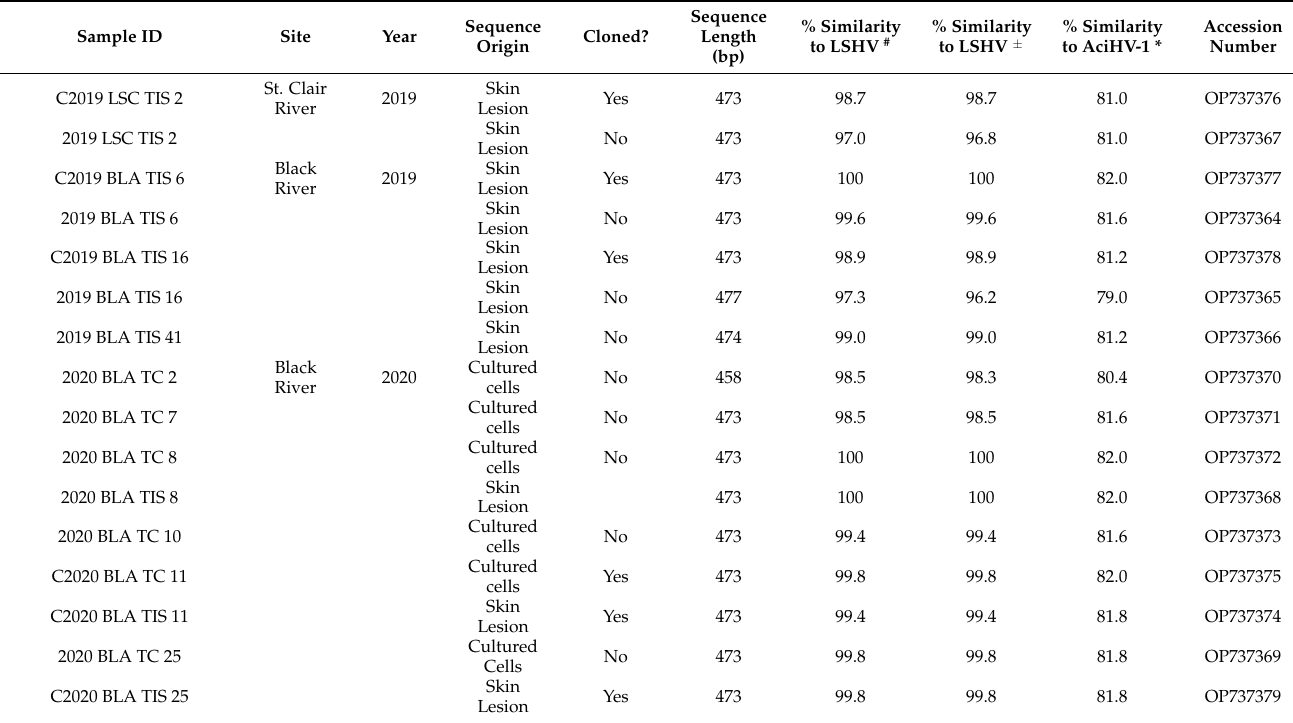
Table 3. Accession numbers and origin of partial DNA polymerase gene sequences (length ranging from 458–477